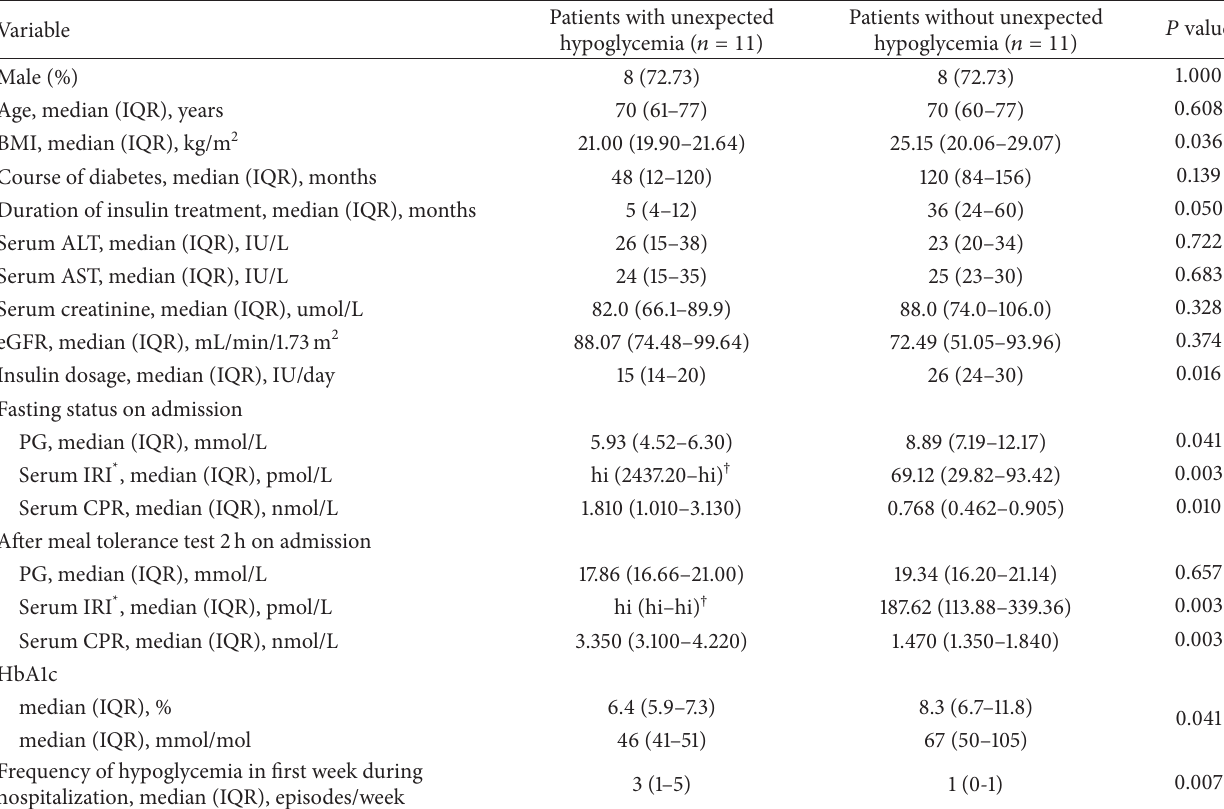
Table 3: Characteristics of the patients with unexpected hypoglycemia and patients without unexpected hypoglycemia.